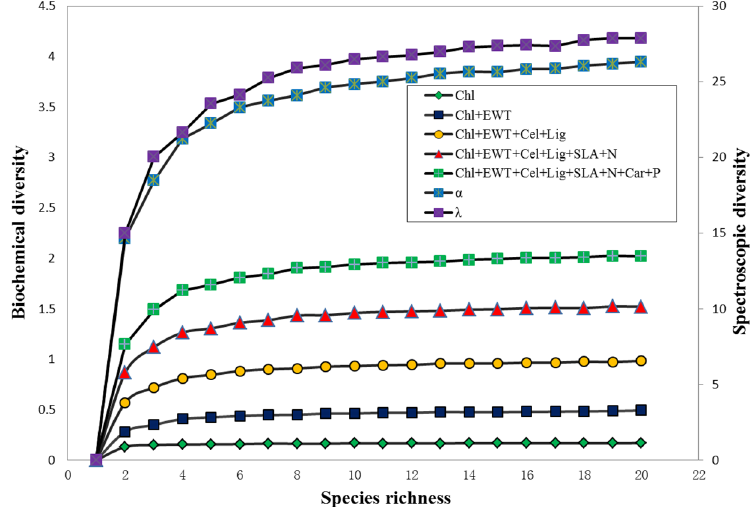
Figure 7 . Change in biochemical and spectroscopic diversity with increased species richness based on the different numbered biochemical component combinations using Monte-Carlo simulation. α denotes the combination of all 16 measured biochemical components. λ denotes the combination of all measured leaf spectral reflectance signatures from 400 to 2400 nm.